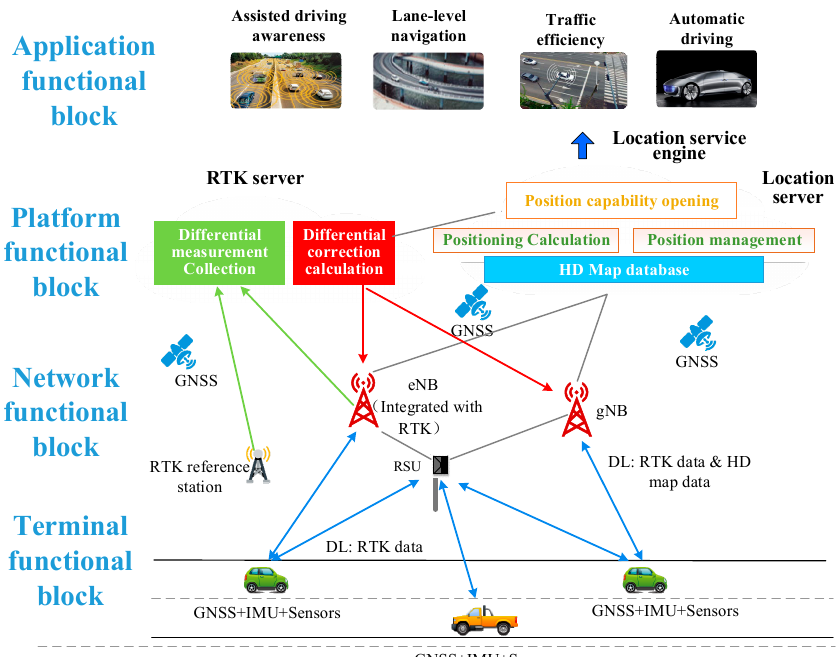
Figure 4. UE-based Positioning Architecture of V2X